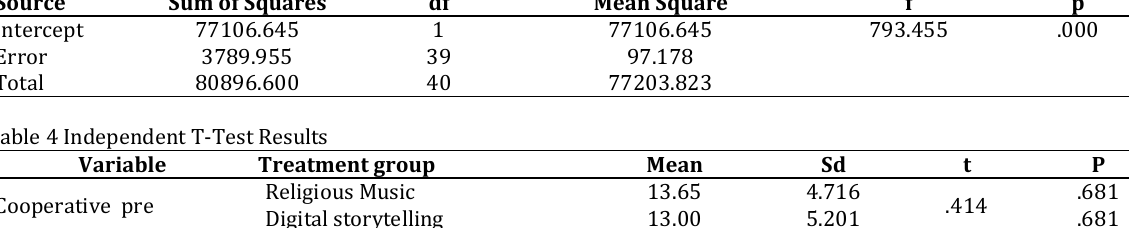
Table 3 Anova Test Repeated Measure Results of Cooperative Differences After Being Given Religious Music and Digital Storytelling